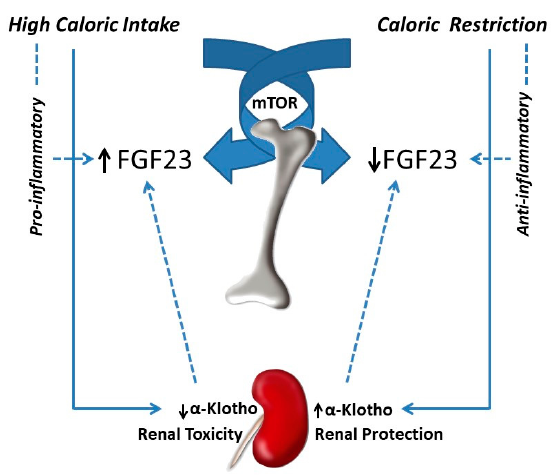
Figure 2. Fibroblast growth factor 23 (FGF23) regulation by caloric intake. High caloric intake increases FGF23, while caloric restriction decreases FGF23. The mechanisms of FGF23 regulation by caloric intake include a direct effect on bone, mediated through the mTOR signalling pathway, and indirect mechanisms, mainly through renal α -klotho regulation. Other indirect mechanisms that may influence FGF23 comprise the inflammatory/anti-inflammatory action of high vs. low caloric intake.